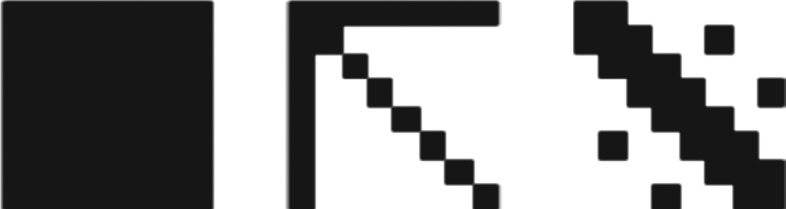
Adjacency matrices for the labelled complete, star and grid graphs.